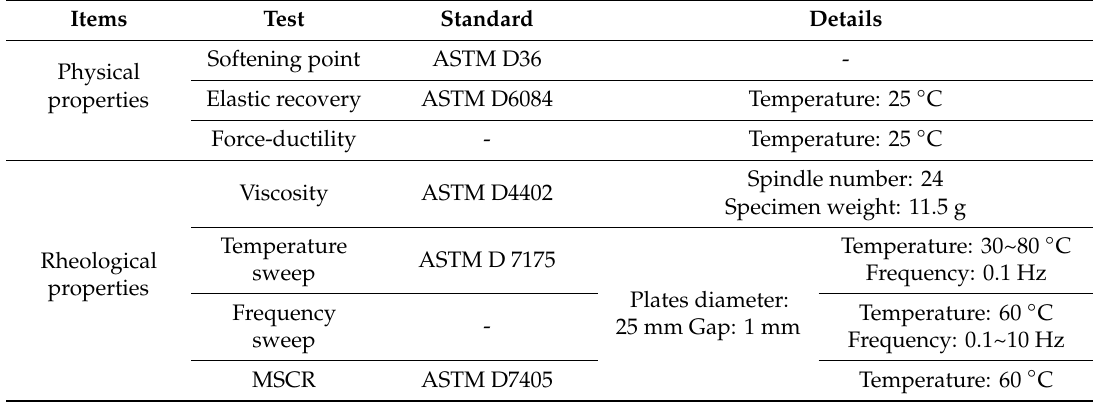
Table 2. Technological tests, normative and devices performed on bitumen